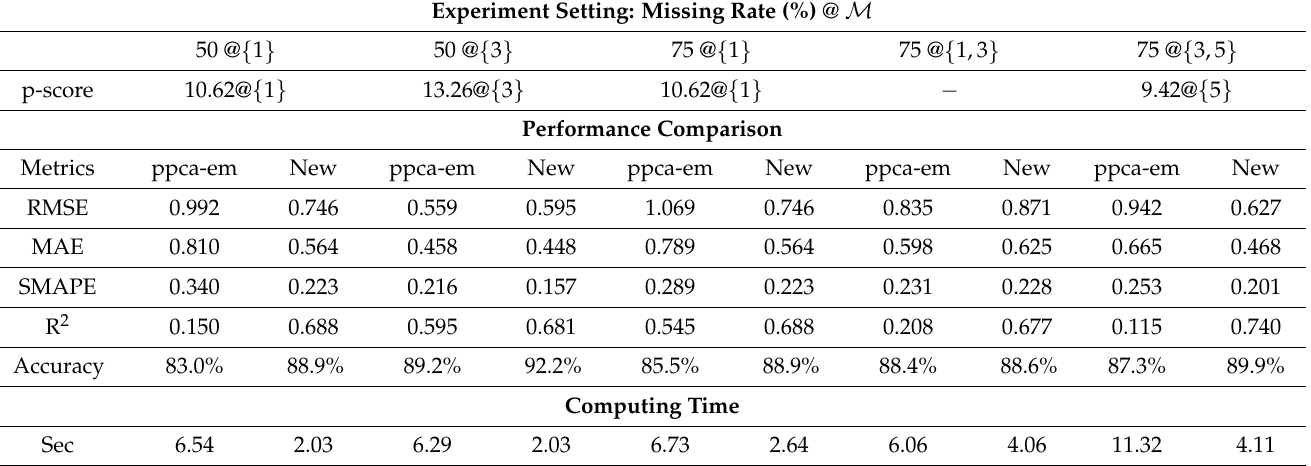
Table 2. Experiment Setting and performance of the algorithms with different Percent of MNAR Data on Links.